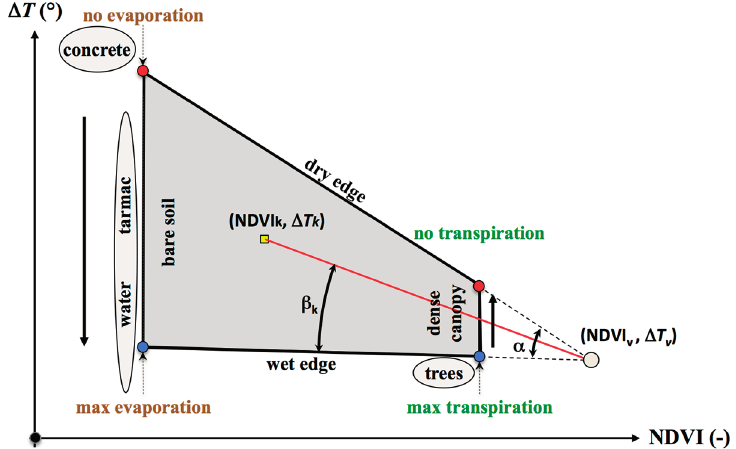
Figure 1. Scatterplot of NDVI vs. Δ T with superimposed dry and wet edges. Blue dots characterize maximum evaporation and transpiration, and minima are represented by red dots. The generic NDVI- Δ T pair is indicated by a K subscript; V subscript represents the triangle vertex.